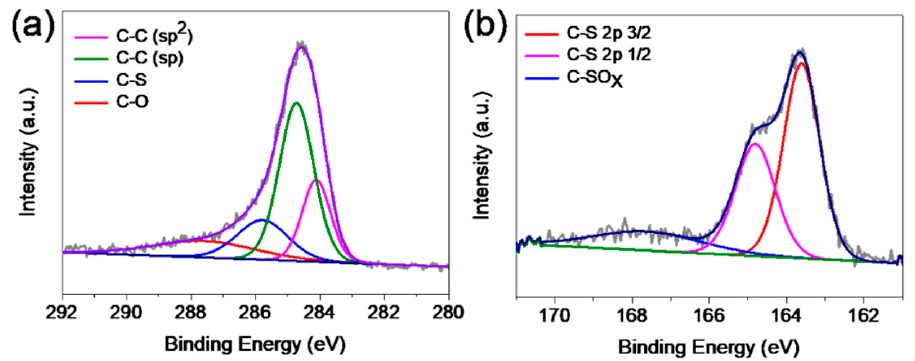
Figure 2. XPS spectra results: ( a ) C 1s binding energy profiles and ( b ) S 2p binding energy profiles.